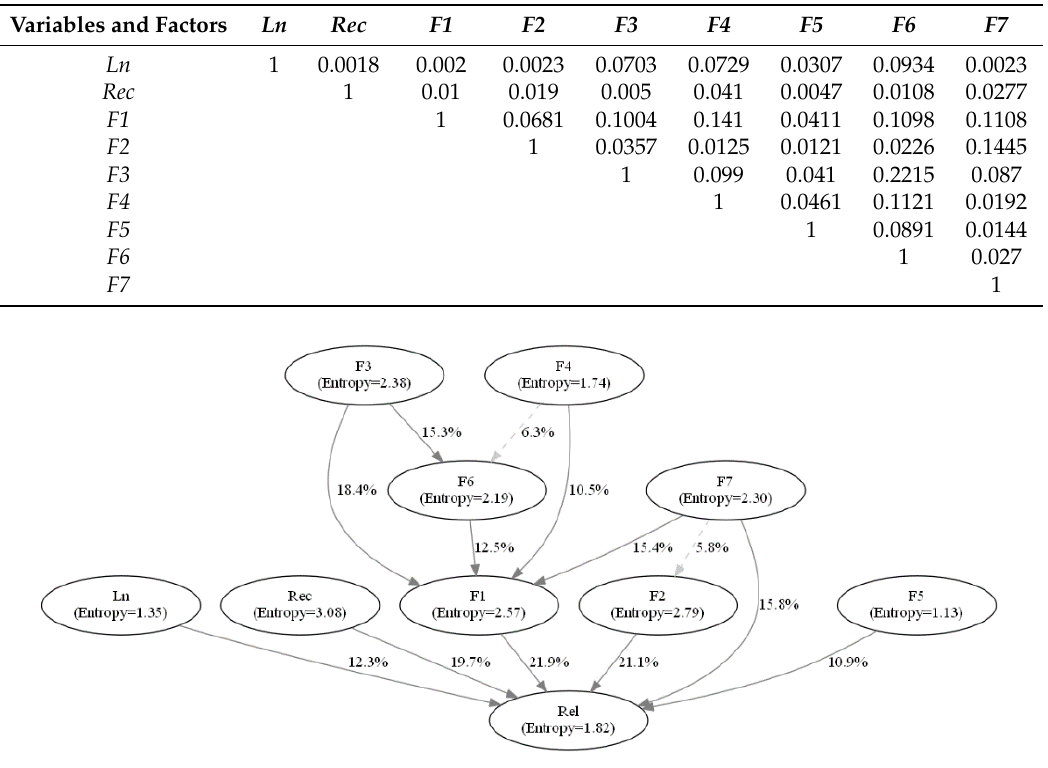
Figure 5. Bayesian network structure with entropy information and link strength percentage.